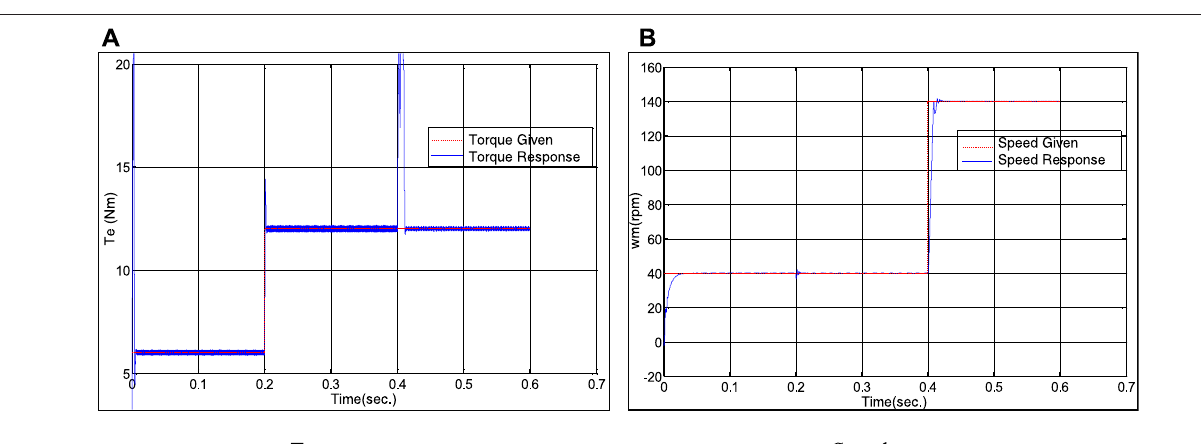
FIGURE 4 | Response curve of inverse system decoupling control.